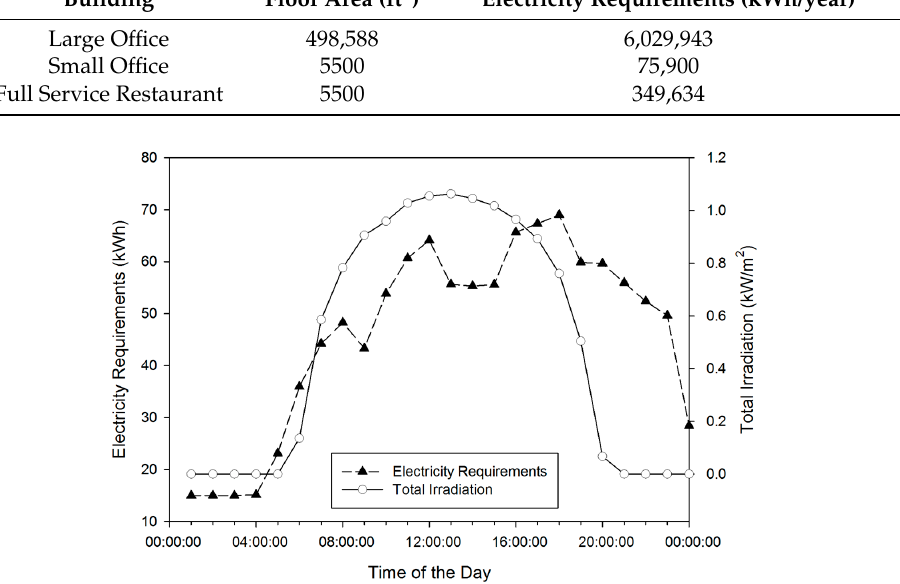
Figure 2. Hourly total irradiation available and hourly electricity requirements for 15 June for the modeled full service restaurant. Table 2. Parameter values used in the model.